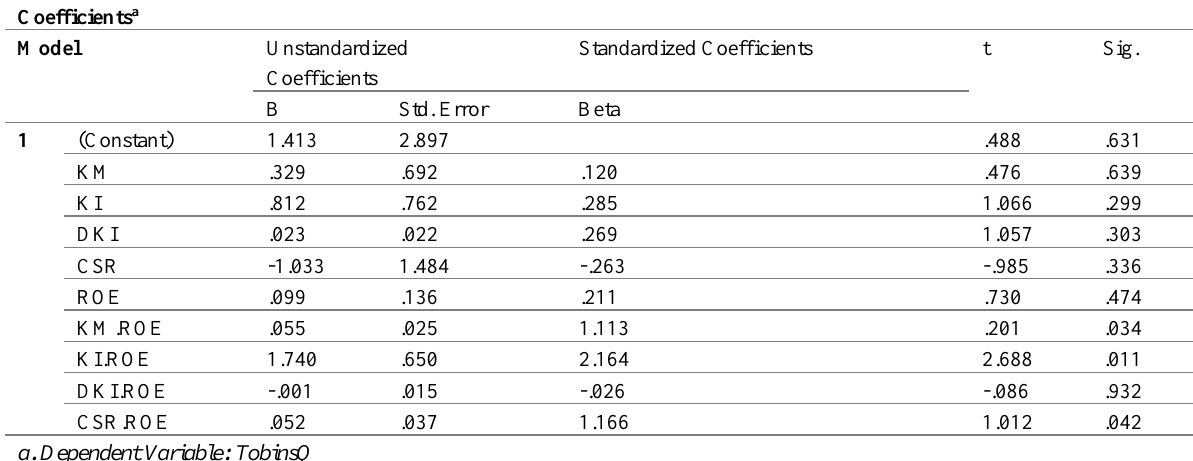
Table 4: Moderate Regression Test Results